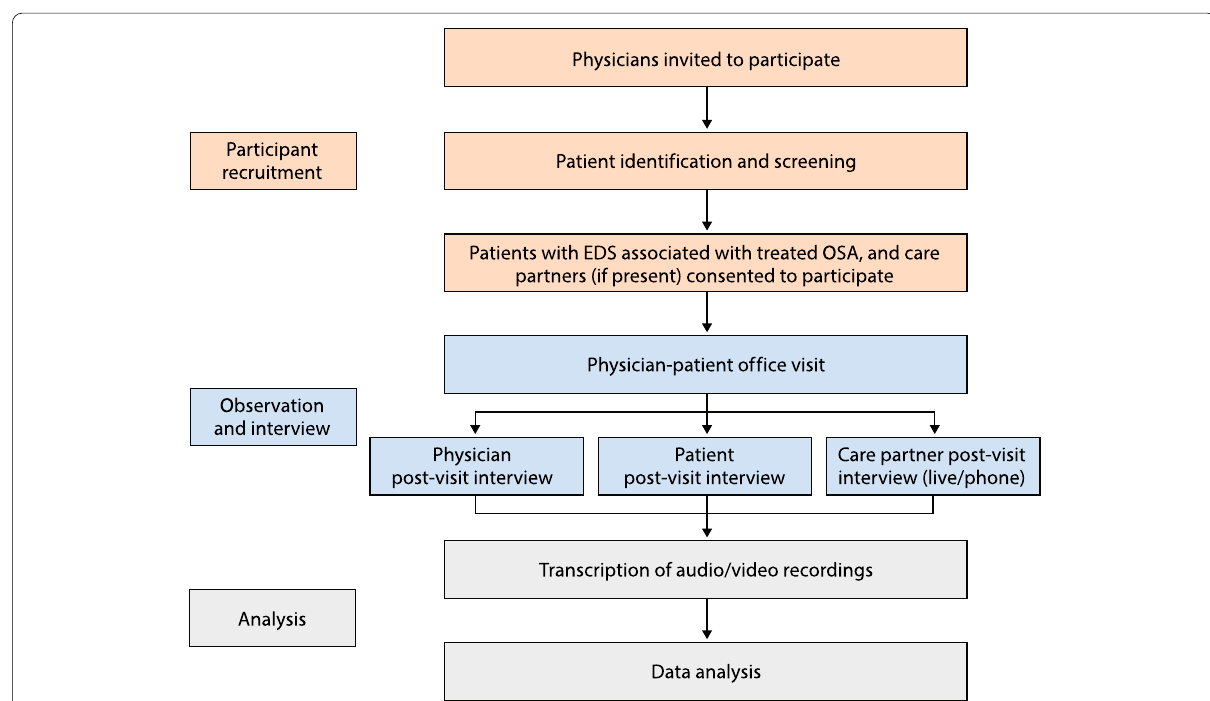
Fig. 1 Study design. Abbreviations: EDS, excessive daytime sleepiness; OSA, obstructive sleep